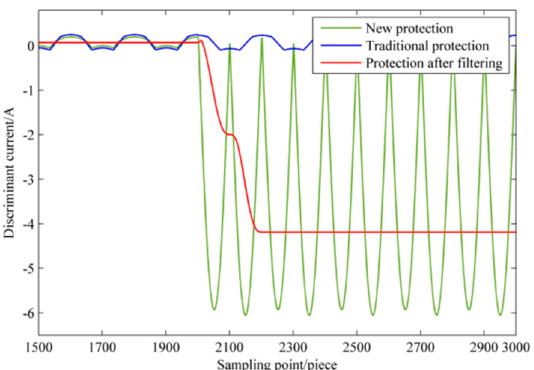
Figure 9. Waveform diagram of fault action current when an external fault occurs on phase B with metallic grounding.